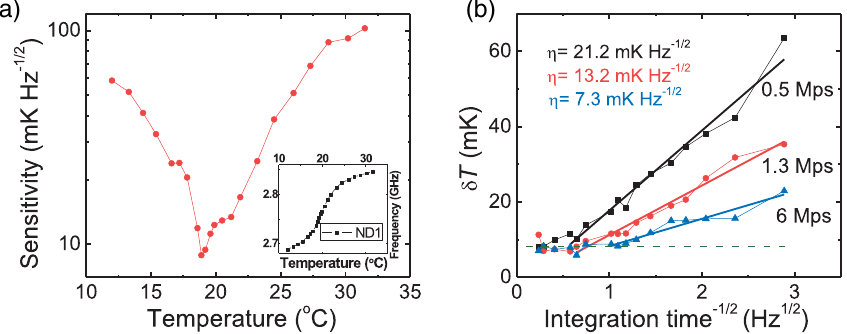
FIG. 3. Sensitivity of a magnetic criticality enhanced Gd-FND temperature sensor. (a) The sensitivity of the hybrid sensor at various temperatures. The red dots are sensitivity determined by Eq. (A2) using the experimentally measured photon counts, ODMR contrast, d ω / dT , and spin resonance width Δ ω . The laser power is chosen such that the photon count is ≈ 6 Mps. The optimal sensitivity ffiffiffiffiffiffi p ≈ 7 . 3 mK/ Hz is achieved at T C ¼ 19 °C. Inset: Frequency shift of the Gd-FND sensor as a function of temperature under an external magnetic field of 100 G. (b) The standard deviation of temperature measurement as a function of data acquisition time for various photon counts (due to different laser powers) using the three-point method. The slopes of the curves give the shot-noise-limited sensitivity of the hybrid sensor. The green dashed line corresponds to the temperature stability of the incubator.